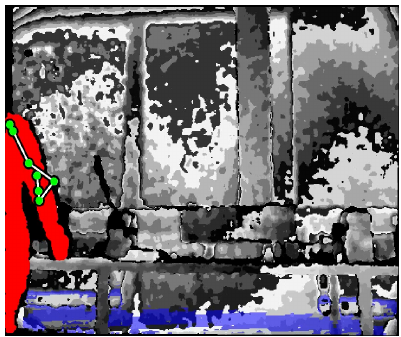
Figure 2. Distorted body detection using the Astra Body Tracker SDK.